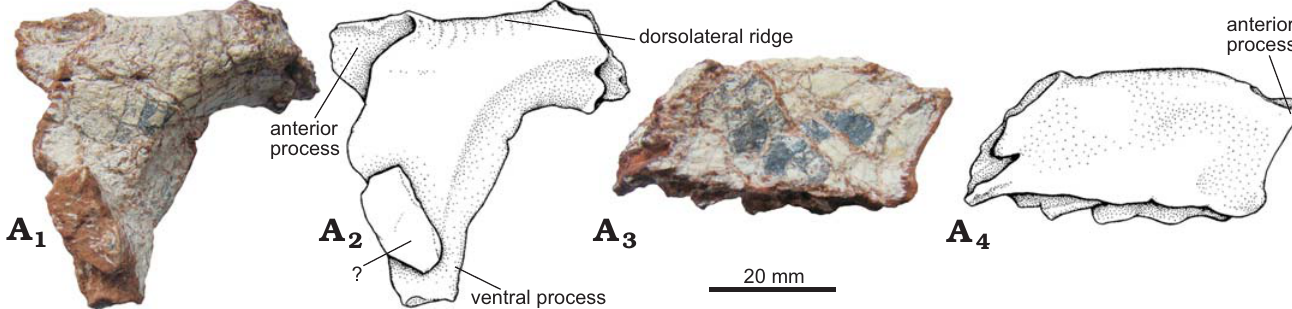
Fig. 9. The pseudosuchian archosaur Prestosuchus chiniquensis Huene, 1938 (UFRGS-PV-0629-T) from the Dinodontosaurus Assemblage Zone, Ladinian, Middle Triassic, Dona Francisca municipality, Rio Grande do Sul State, Brazil; left prefrontal in lateral (A 1 , A 2 ) and dorsal (A 3 , A 4 ) views. Photographs (A 1 , A 3 ) and explanatory drawings (A 2 , A 4 ).